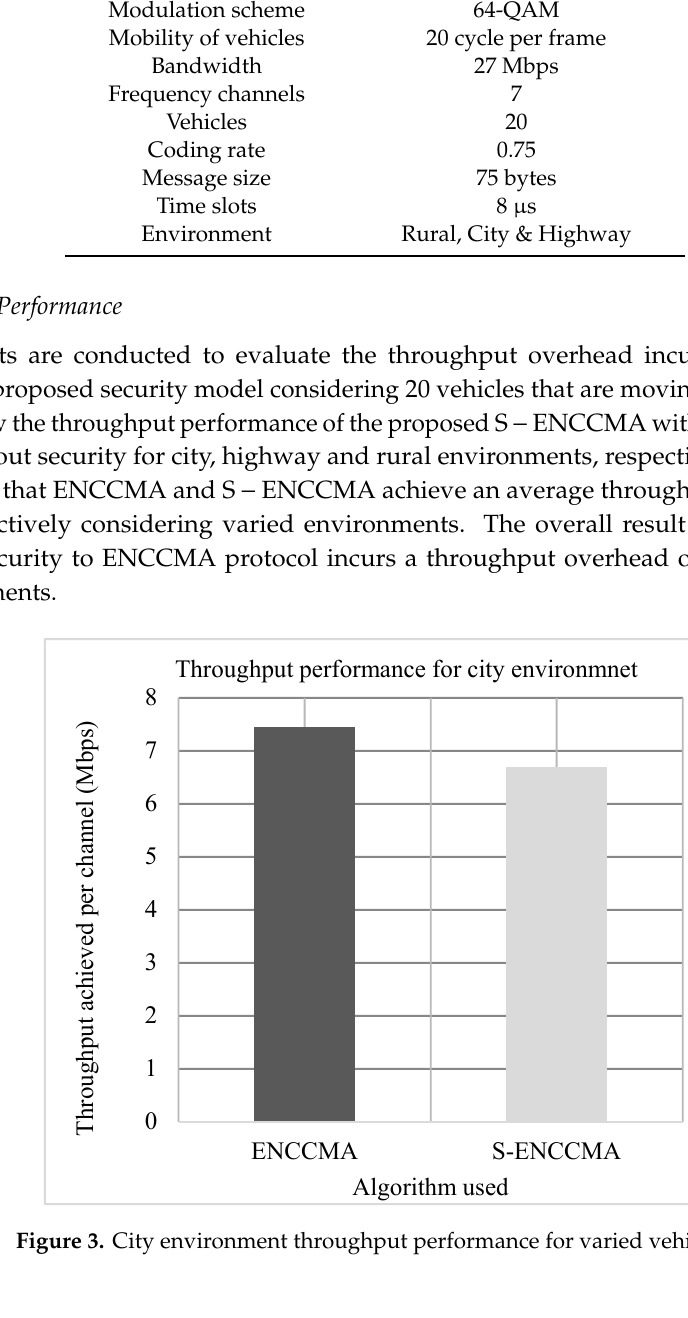
Figure 4. Highway environment throughput performance for varied vehicles. Algorithm used